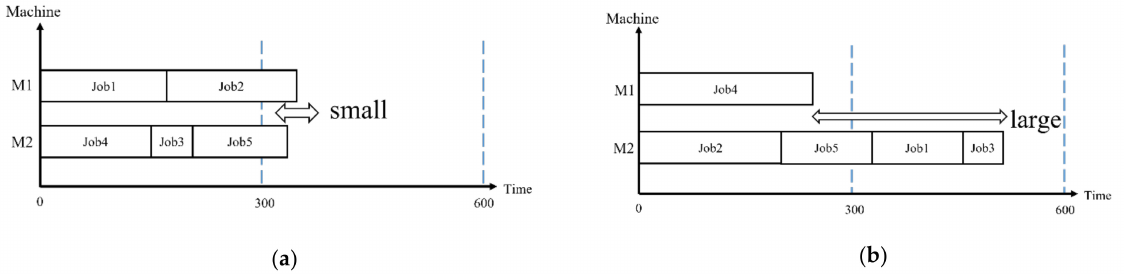
Figure 3. Gantt charts with different weighting factor: ( a ) maximum completion time is emphasized; ( b ) maximum completion time is not